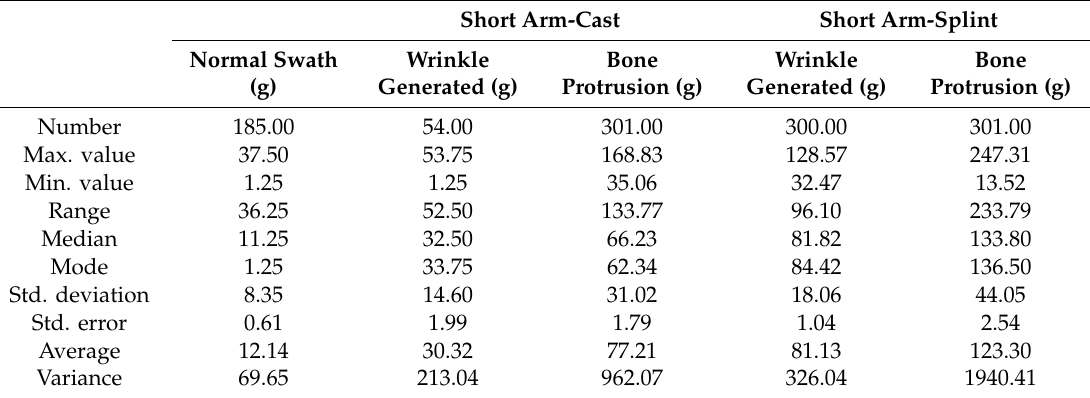
Table 2. Actual analysis for the utilization of a short arm-cast and a short